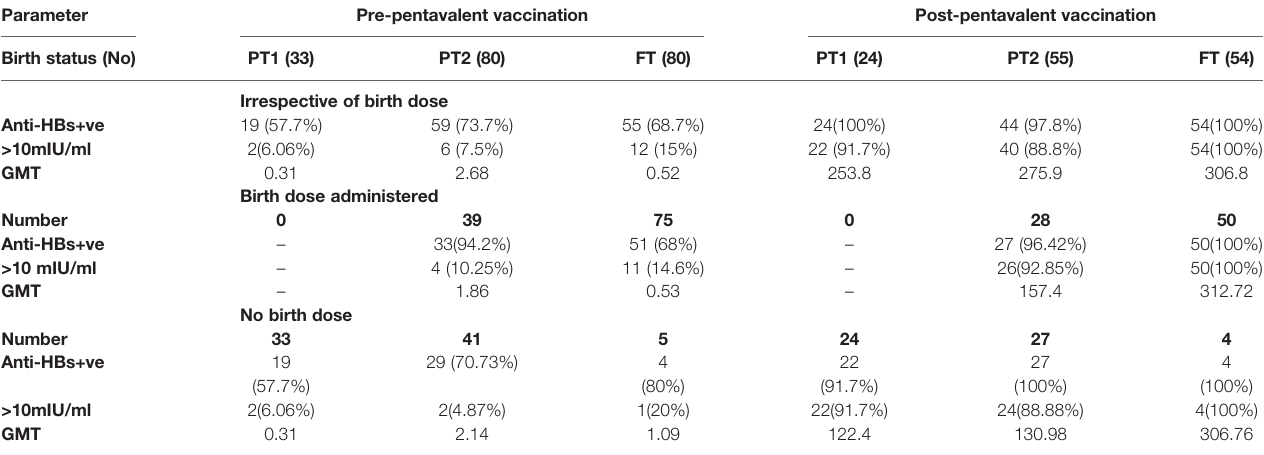
TABLE 4 | Anti-HBs IgG titres in all study groups categorized on the basis of HBV birth dose administration.